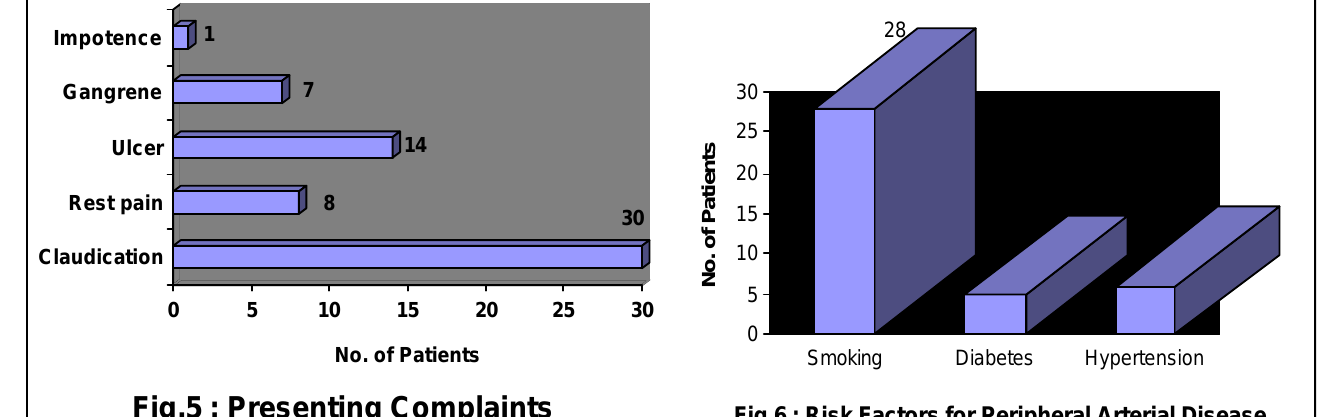
Fig.6 : Risk Factors for Peripheral Arterial